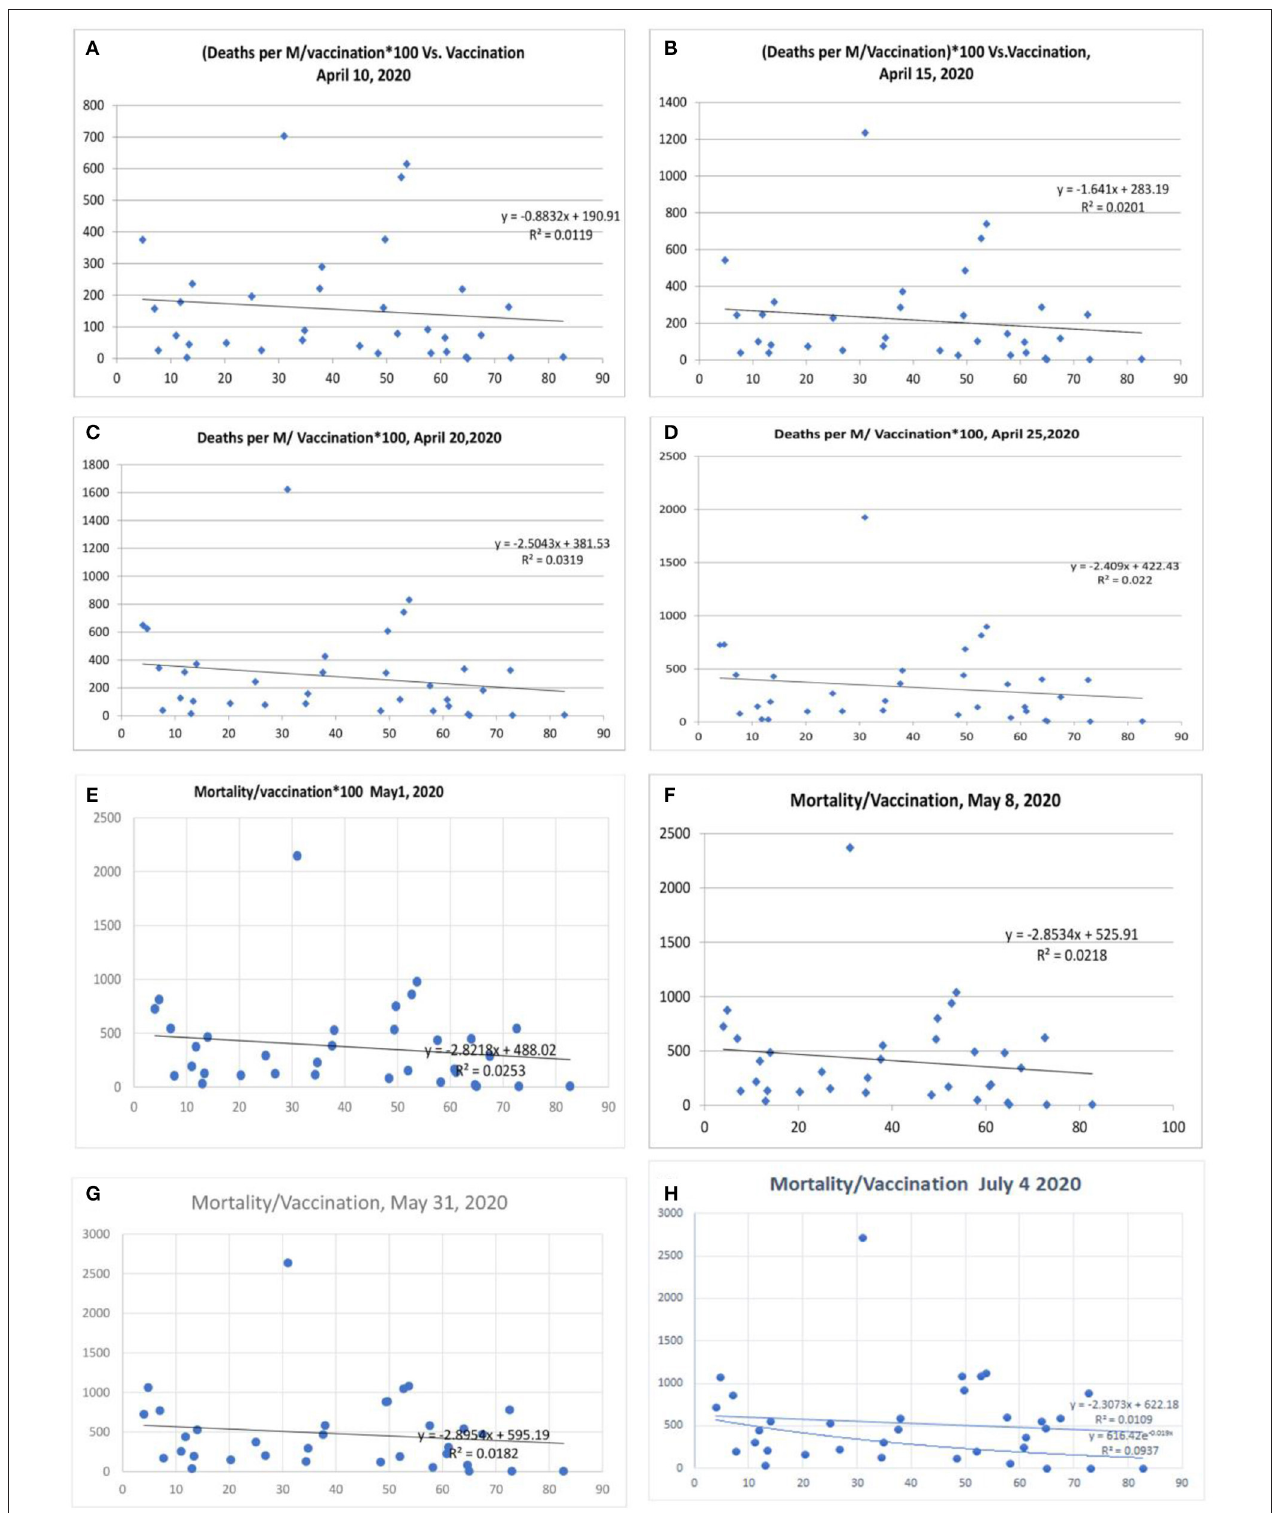
FIGURE 2 | Correlation between influenza vaccination percentage (age ≥ 65 years) and mortality per million population/vaccination percentage [ (A) April 10, 2020, (B) April 15, 2020, lower panel April 20, 2020, (C) April 20, 2020, (D) April 25, 2020, (E) May 1, 2020, (F) May 8, 2020, (G) May 31, 2020, and (H) July 4, 2020].